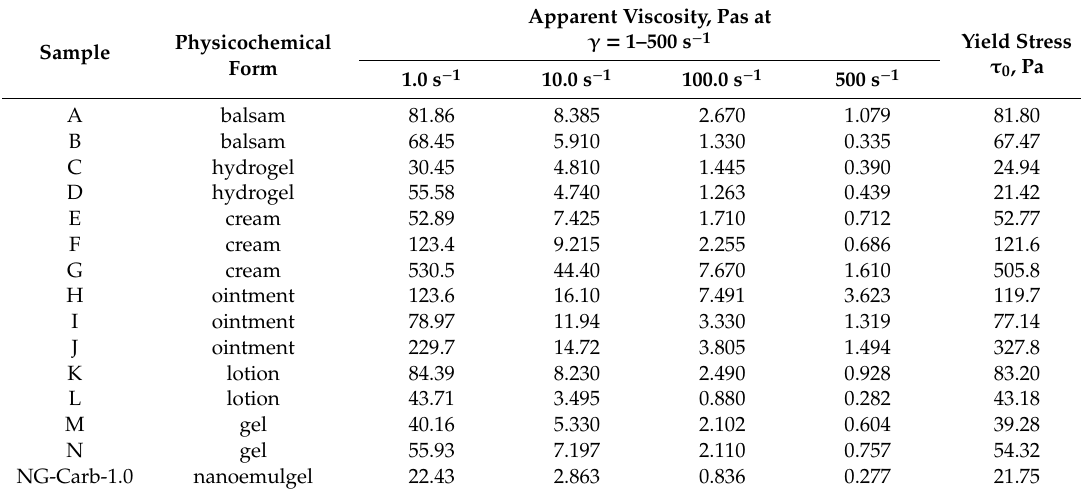
Table 5. Rheological characteristics of the tested